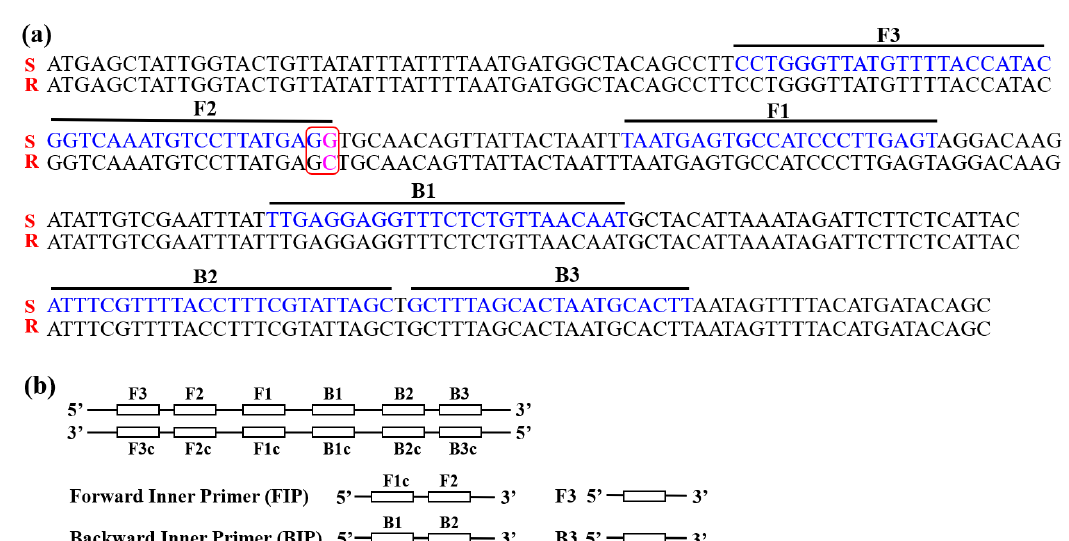
Figure 1. LAMP primers for the G143A mutation of Cyt b in Corynespora cassiicola . ( a ) Sequence alignment of sensitive and resistant Cyt b alleles. The sequences used as LAMP primers are indicated by vertical lines. For each mutation, the F2 primer ends with its corresponding G143A mutant nucleotide. ( b ) Schematic diagram of LAMP primers used in this work. The internal primer FIP is composed of F1c and F2, whereas BIP is composed of B1 and B2c. The primers ending with “c” are complementary to the primers without “c”.